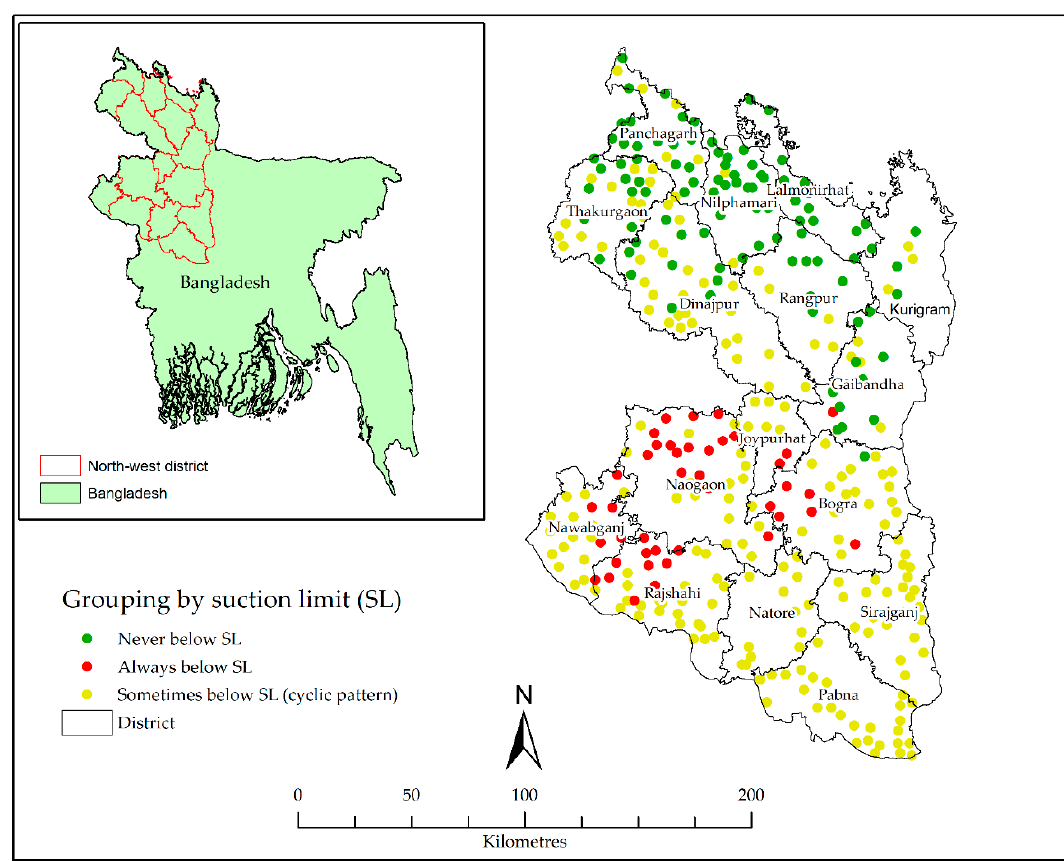
Figure 3. Distribution of the groundwater table (GWT) monitoring well-types based on suction lift limit in 16 districts in the North-West hydrological region of Bangladesh.